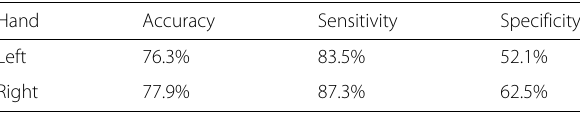
Table 2 Results of laboratory tests for a simple threshold-based model